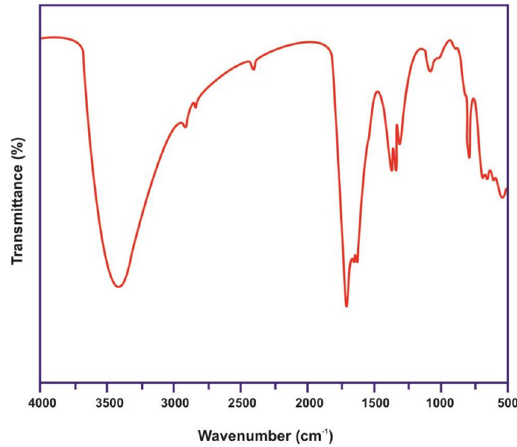
O nanoparticles. 2 4